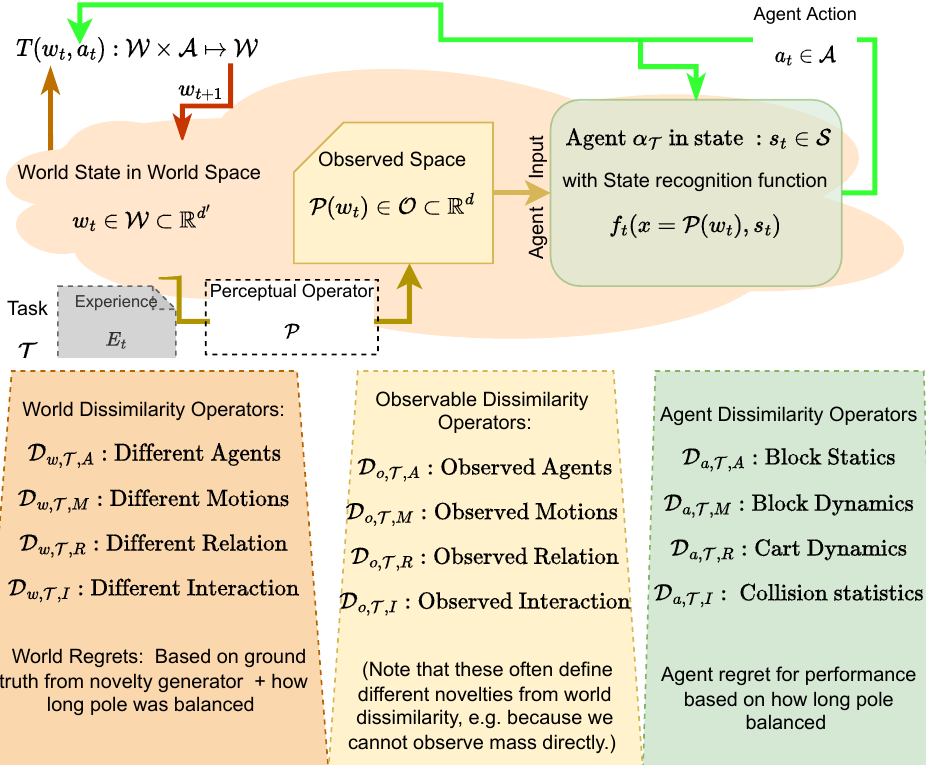
Figure 2. In the Boult et al. [4] framework for novelty, the critical elements for defining novelty are D task-dependent dissimilarity functions D w , T ; E o , T ; E t , and associated thresholds δ w and δ o for the t world and observational space respectively. This paper shows that multiple dissimilarity operators support defining multiple subtypes of novelty (e.g., novel agents, novel actions by agents, novel interrelations, etc). We also define a WOW-agent agent-dissimilarity-operator and show how to use Extreme Value Theory (EVP) to deal with the inherent uncertainty in the world while defining an effective threshold δ a for the WOW-agent to declare novelty subtypes. Finally, we show that EVP can be effectively used to determine probabilities and the novelty detection thresholds in a 3D CartPole